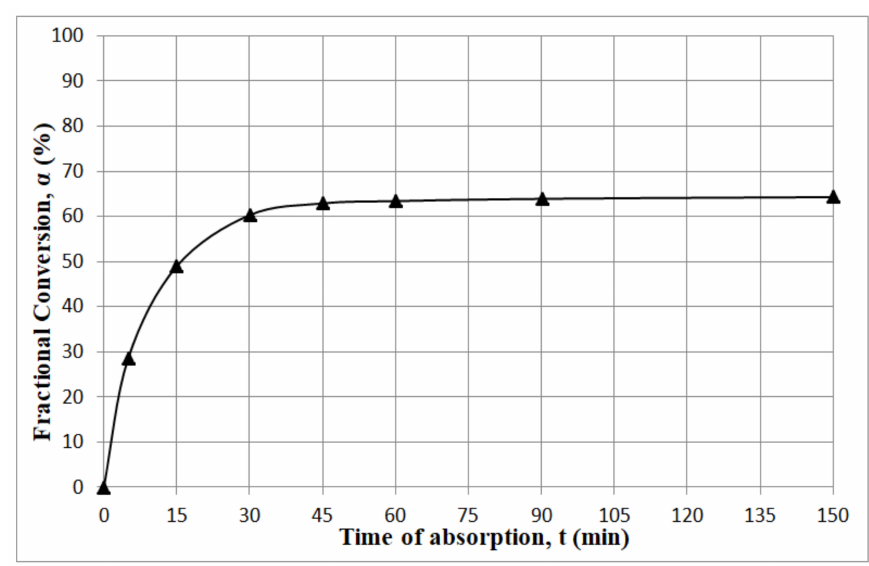
Figure 6. Relationship between the fractional conversion of soda lime and time of carbon dioxide absorption.